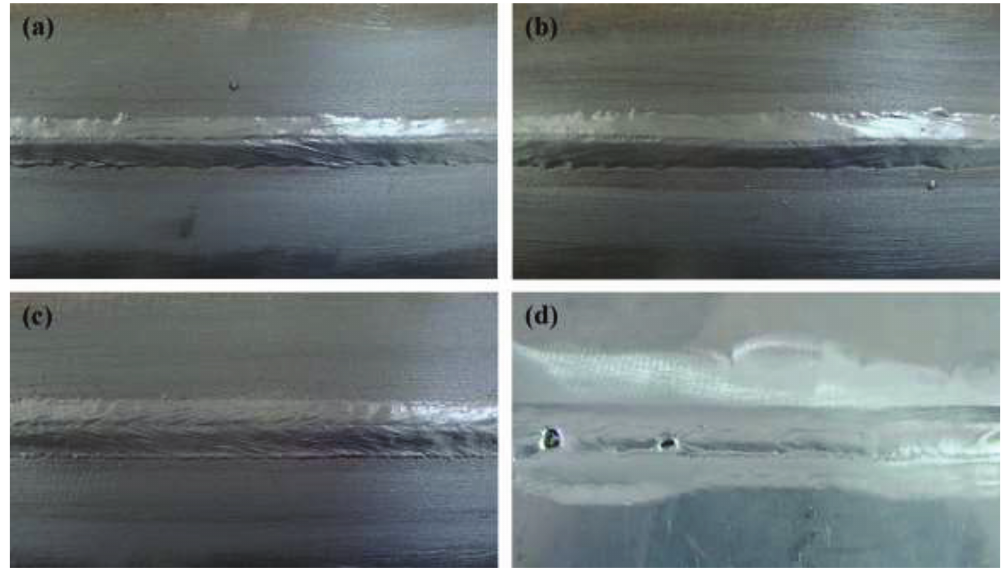
Figure 4: Appearances of butt weld seams under different welding speeds: (a) 1100 mm/min, (b) 1150 mm/min, (c) 1200 mm/min and (d) 1250 mm/min.